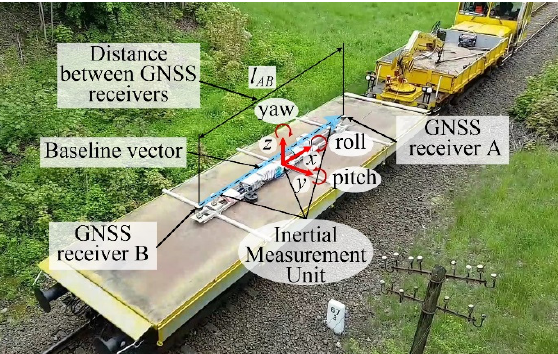
Figure 3. The measuring platform with GNSS and IMU units’ placement, where: yaw, roll, and pitch represent, respectively, the direction, and lateral and longitudinal inclination angles of the track.